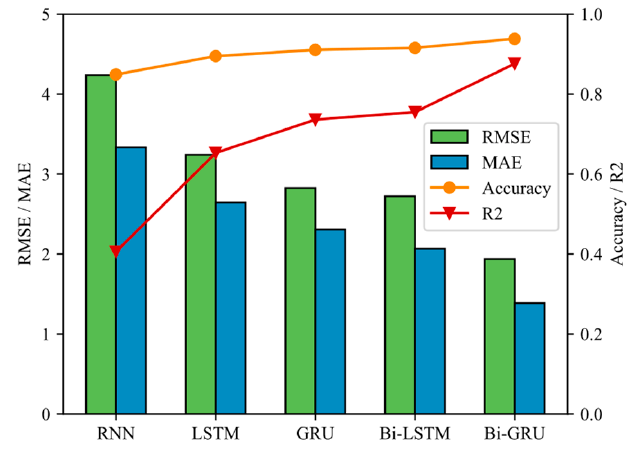
Figure 8. Comparison of prediction accuracy.